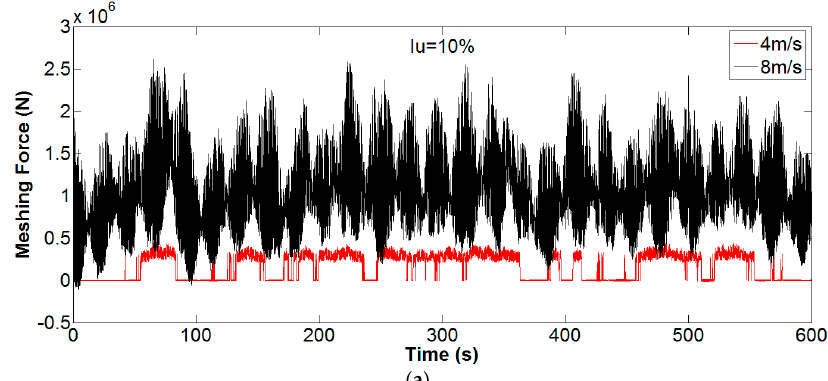
Figure 7. Statistics of of WT main shaft’s torques of mean wind speeds varying from 4 to 22 m/s: ( a , b ) 10%; ( c , d ) 20%; ( e , f ) 30%.